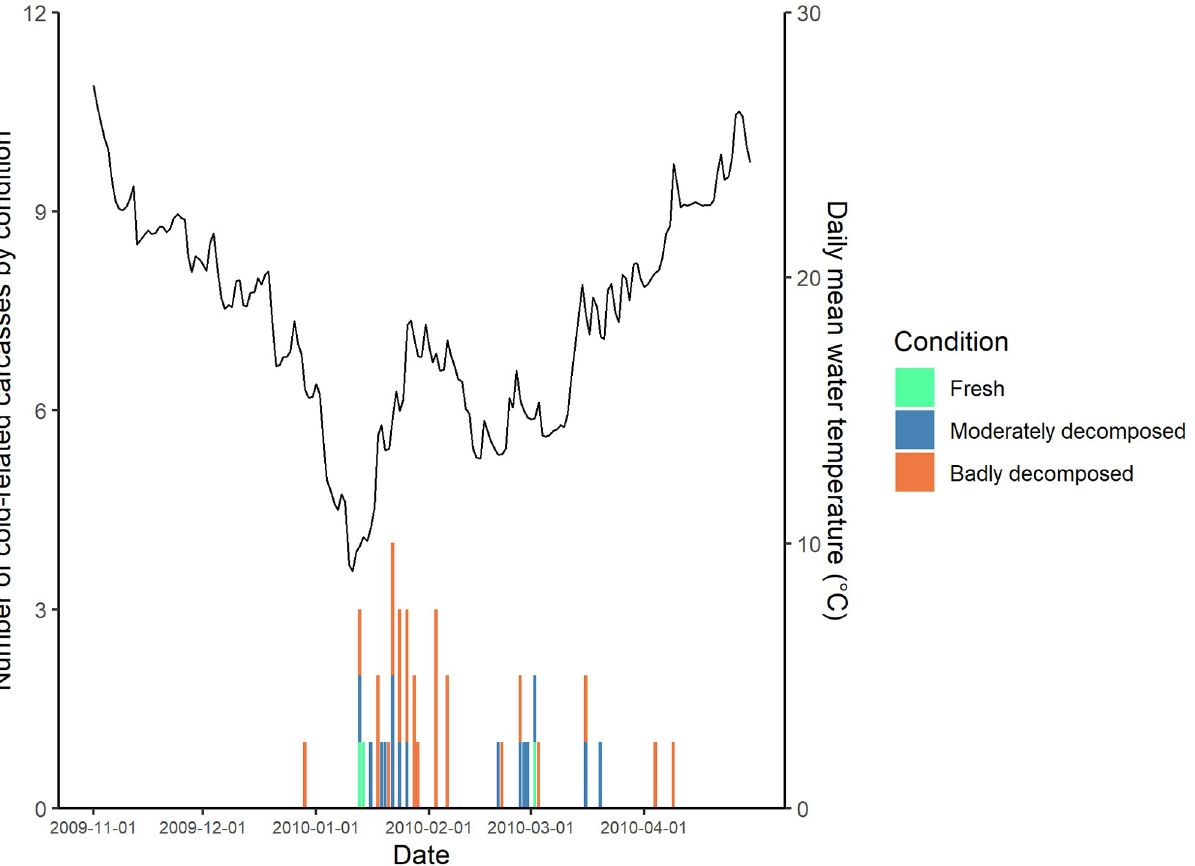
Fig 8. Number of cold-related manatee carcasses reported by day and condition code in the central-west (CW) region during winter 2009–2010. Mean daily water temperature from the TECO Big Bend Power Station intake (see Fig 1) is plotted in black. Note that the scales on the y-axis for carcass counts differ between Figs 7 and